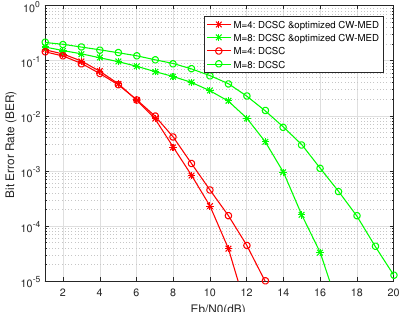
Figure 5. Comparison of BER performance of